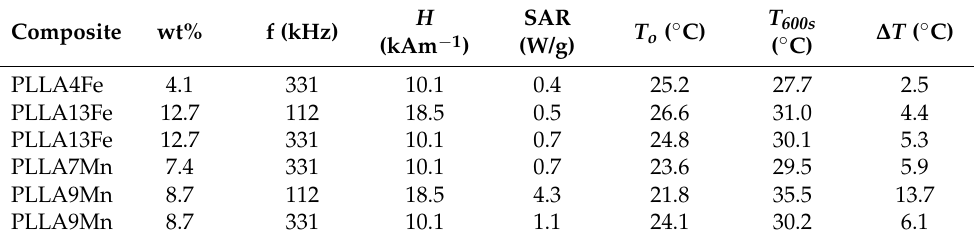
Table 3. Composite material, wt% of MNPs in PLLA, frequency ( f ), magnetic field amplitude ( H ), specific absorption rate (SAR), initial temperature ( T o ), temperature after 600 s of EM field treatment ( T 600s ), temperature increment ( ∆ T